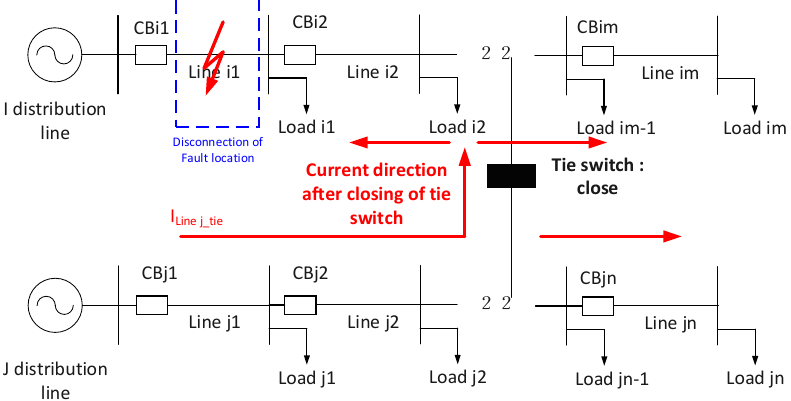
Figure 3. Current flow after the tie switch is closed.